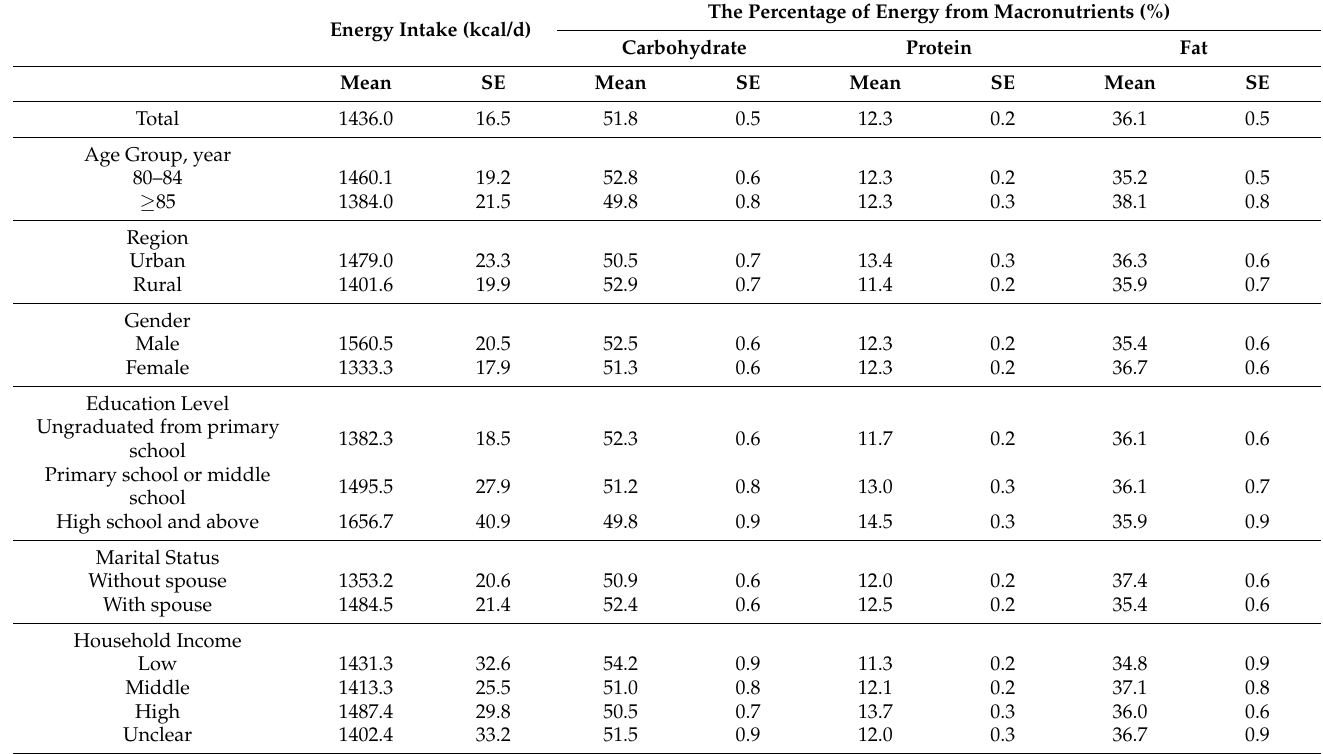
Table 8. Daily dietary energy intake and the estimated percentage of energy intake from macronutrients in subjects. The Percentage of Energy from Macronutrients (%) Energy Intake (kcal/d) Carbohydrate Protein Fat Mean SE Mean SE Mean